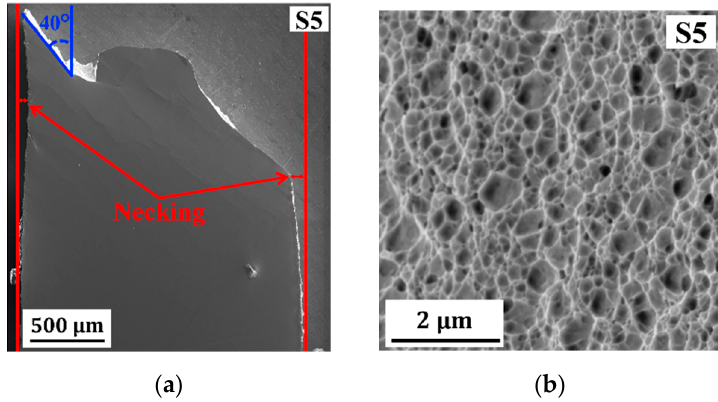
Figure 6. ( a ) SE images of surface morphology at the gauge section after tensile test of sample 5 (S5); ( b ) a SE image of the fracture surface of sample 5 (S5) showing ductile fracture with dimple structures.